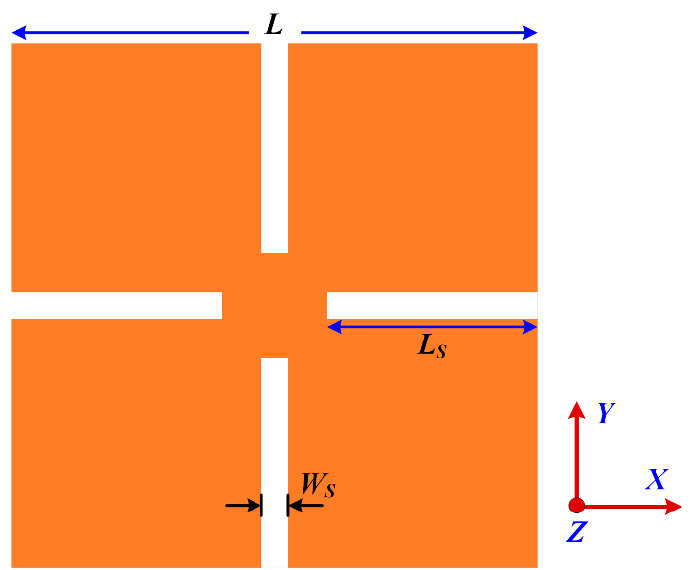
Figure 1. The geometry of the proposed slotted square patch ( L = 20 mm).